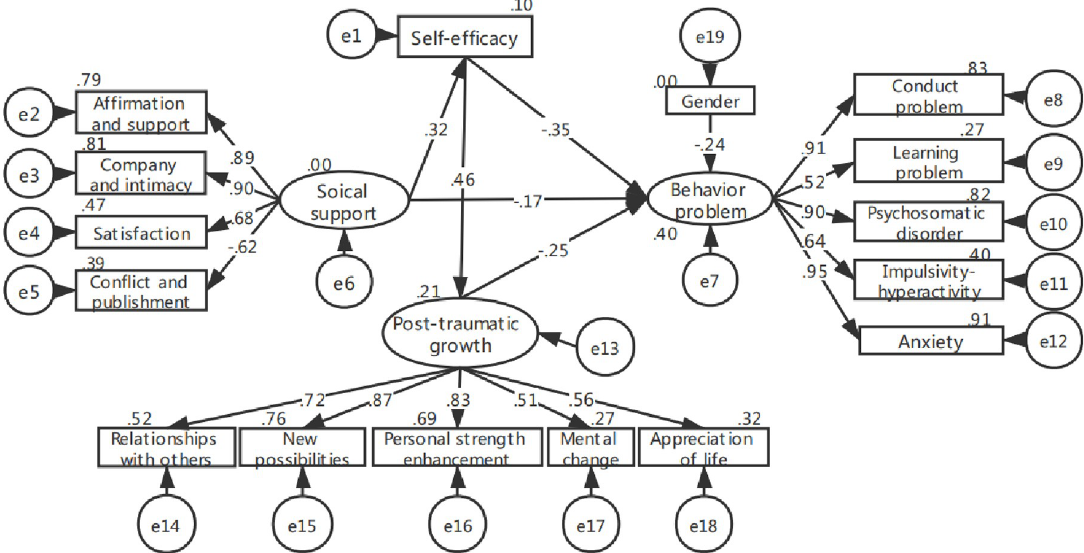
Fig 2. The second model of behavior problems among 8~18 years old children with malignant tumors.